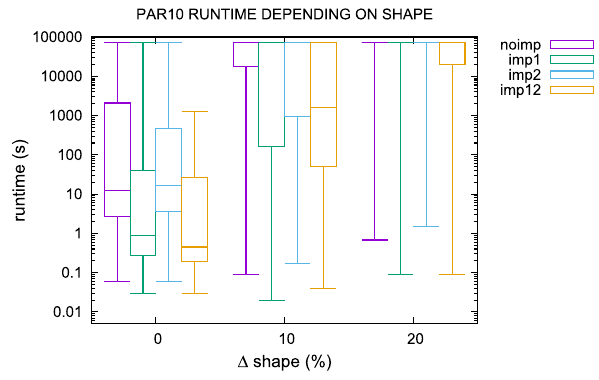
Fig. 3 PAR10 (in seconds) of solving real-world B2B instances, with and without using implied constraints, varying their density d , and T = Δ L with a fixed shape, i.e., Δ